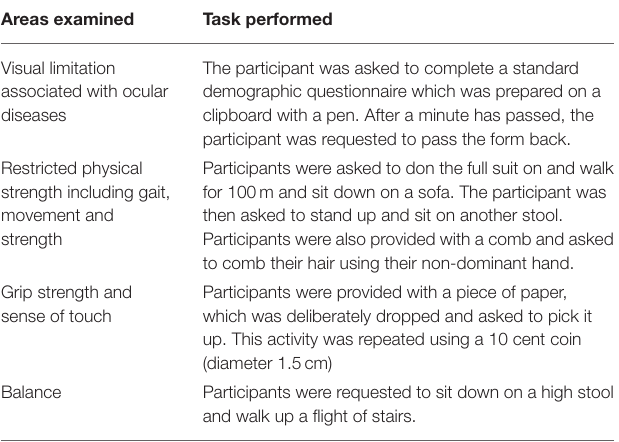
TABLE 1 | Areas of aging experienced by students and tasks performed. Areas